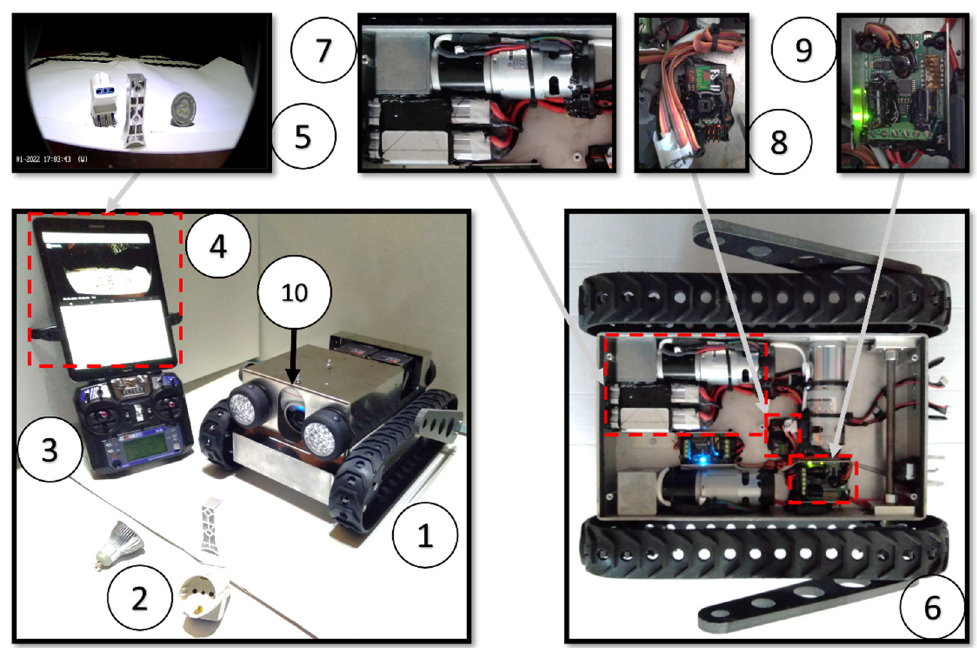
Figure 2. Overall scheme of the mechatronic system: (1) robot; (2) objects on the path; (3) RC controller; (4) HMI interface; (5) view of the camera on board; (6) internal view of the robot-control boards; (7) zoom-in view of the actuator and lithium battery pack; (8) Spektrum Receiver Mk610; (9) electronic board for motor control ; (10) front camera for vision.